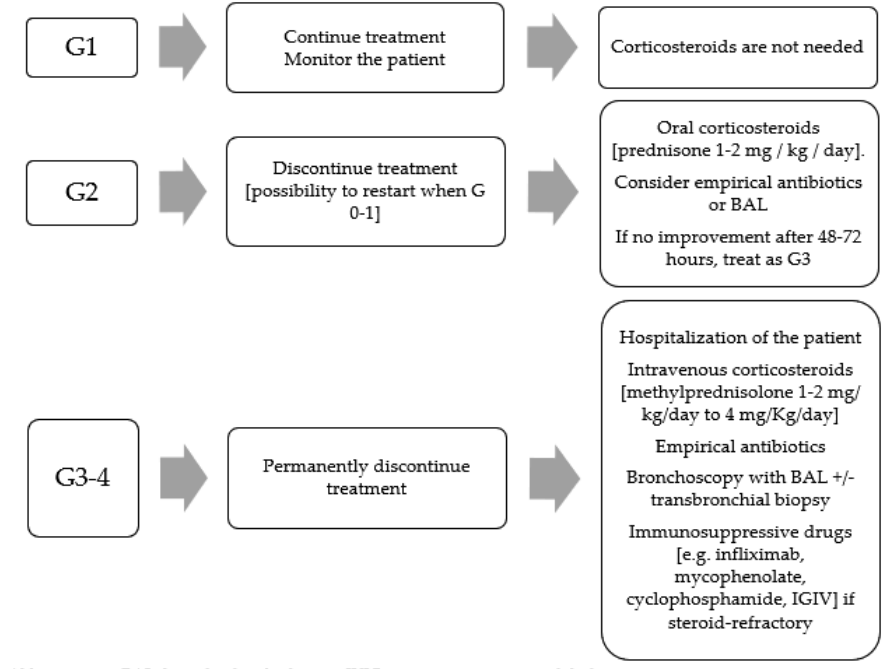
Figure 3. Management of pneumonitis according to severity.